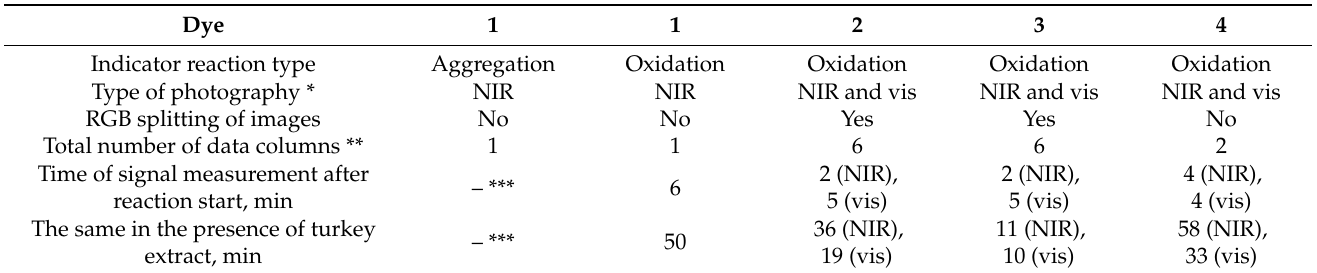
Table 1. Indicator reactions used in the discrimination studies and the details of photographic registration of the